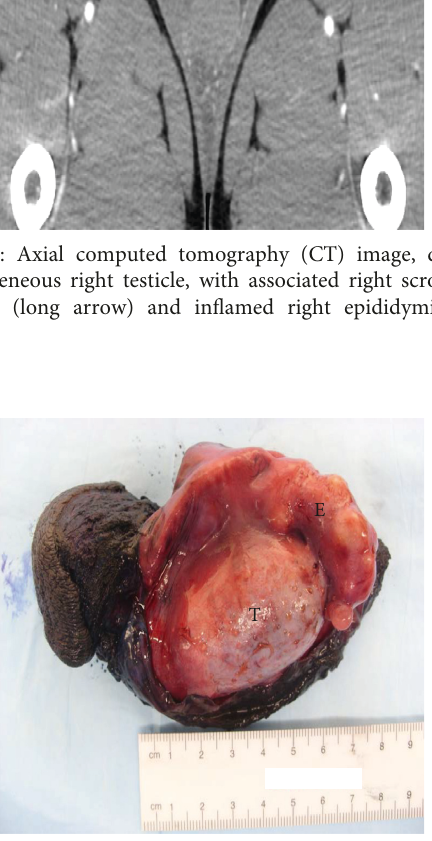
Figure 2: Opened scrotal sac with the exposed testicle (T) and enlarged and nodular epididymis (E).